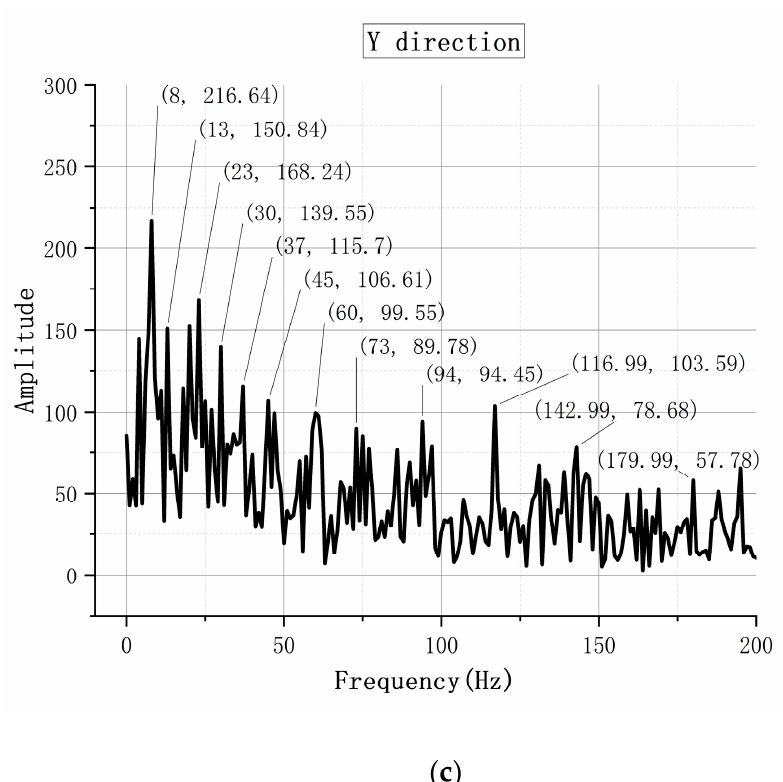
Figure 7. Results of frequency composition analysis. It is the result of the frequency composition analysis of the three-dimensional force in Figure 6. ( a ) The frequency composition of the Z-direction force. ( b ) The frequency composition of the X-direction force. ( c ) The frequency composition of the Y-direction force.